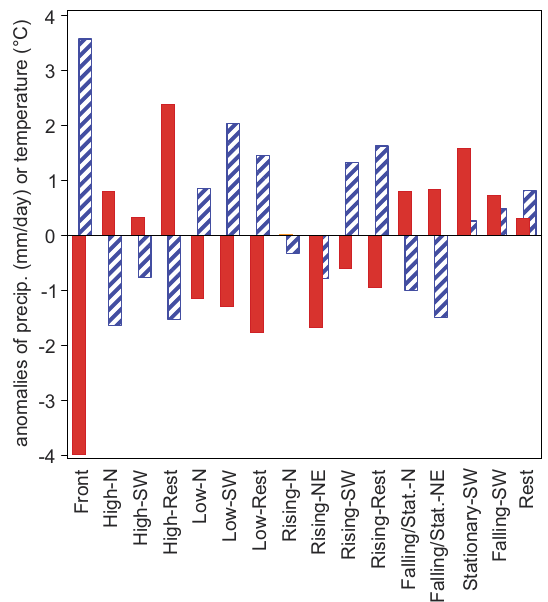
Fig. 5. Temperature anomalies (red) and precipitation (blue pat- terned) averaged for each weather type for the summer months (June to August) in the reference period. Note that for visualization purposes, precipitation is plotted as anomalies from the seasonal mean whereas the sampling operates with absolute